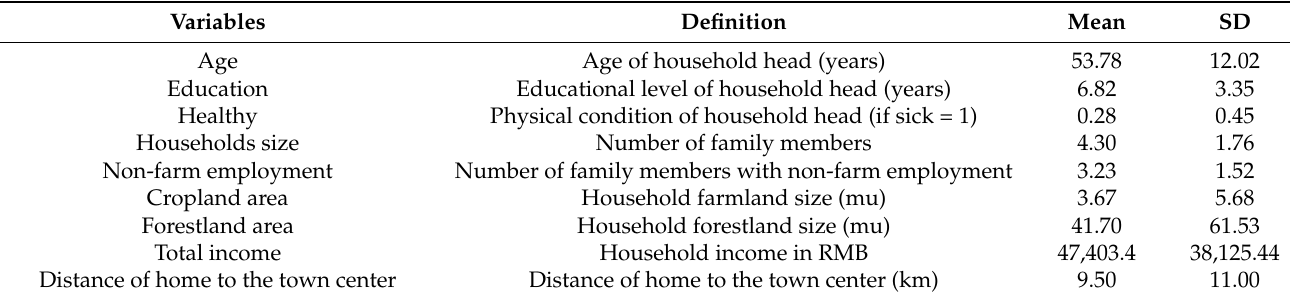
Table 3. Descriptive statistics of selected variables.